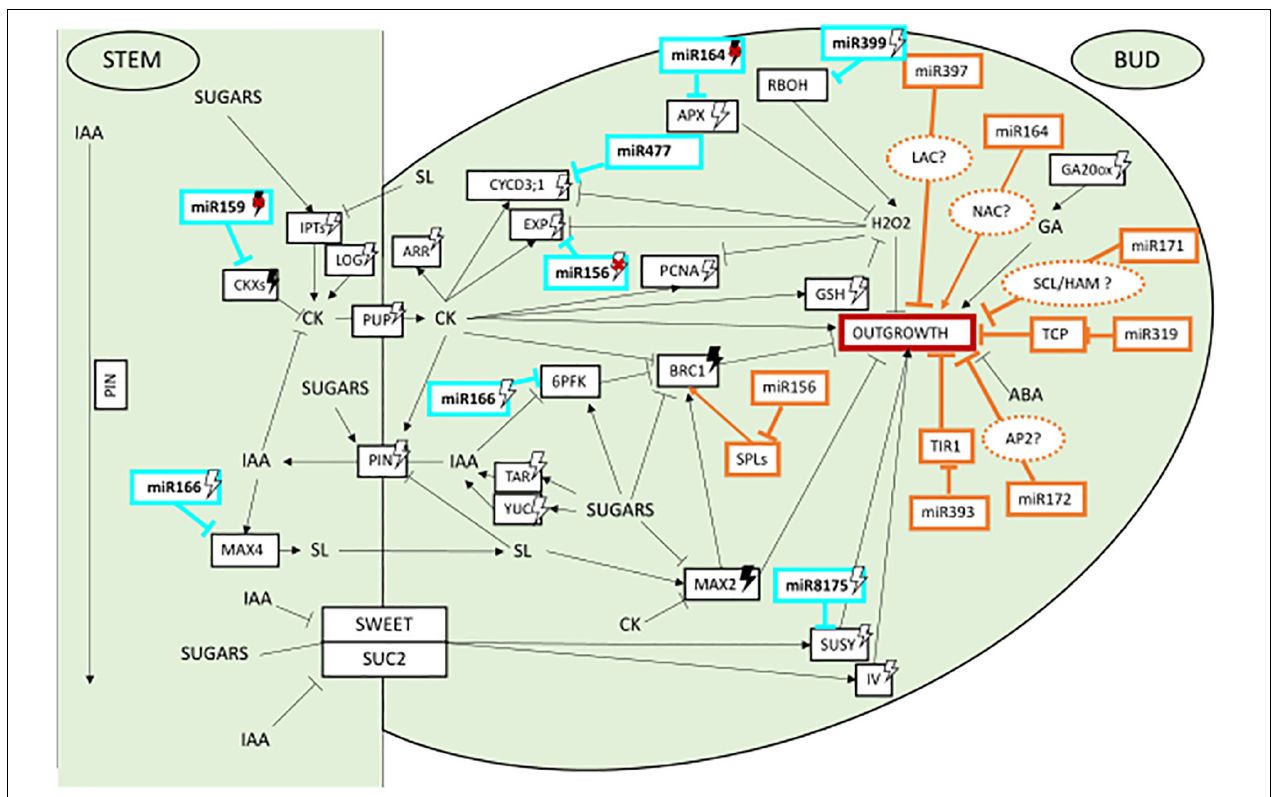
FIGURE 2 | Potential role of miRNAs in the control of axillary bud outgrowth and their light regulation in plants. In bright blue miRNAs identified in the present study as putative novel regulators in control of bud outgrowth. Black arrows heads mean induction, straight lines mean repression, white lightning bolt means induction by light, darked lightning bolt means induction by darkness, red cross means repression of the miRNA.